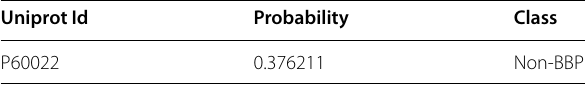
Table 2 Probability of penetration of β-defensin 1 through